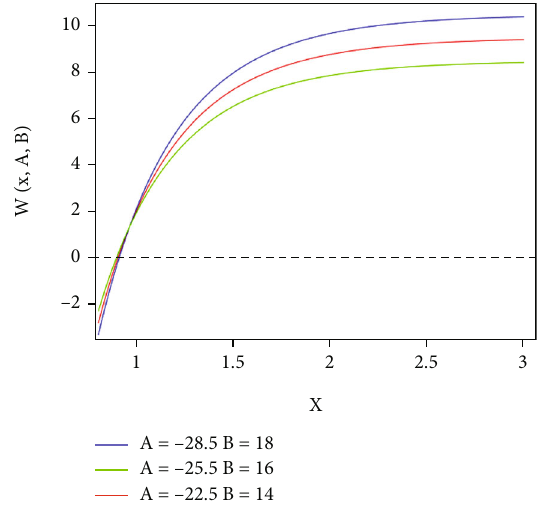
Figure 3: Partner Potentials V